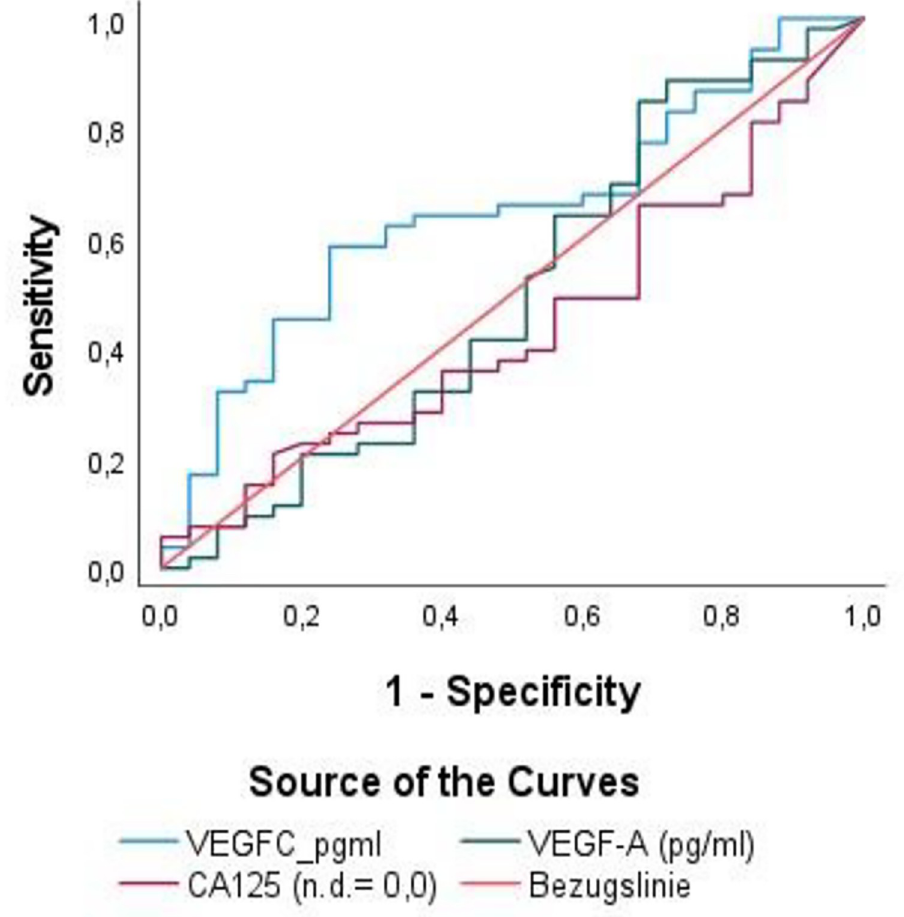
Fig 1. ROC curves for VEGF-C, VEGF-A and CA125 serum levels as markers for becacizumab therapy response.